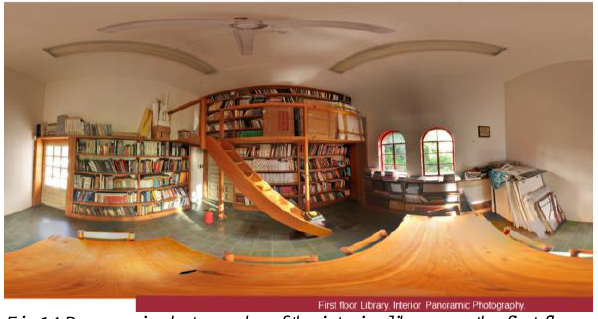
Fig.14 Panoramic photography of the interior library on the first floor. Authors: Adam Weigert and U Cheng Vong .